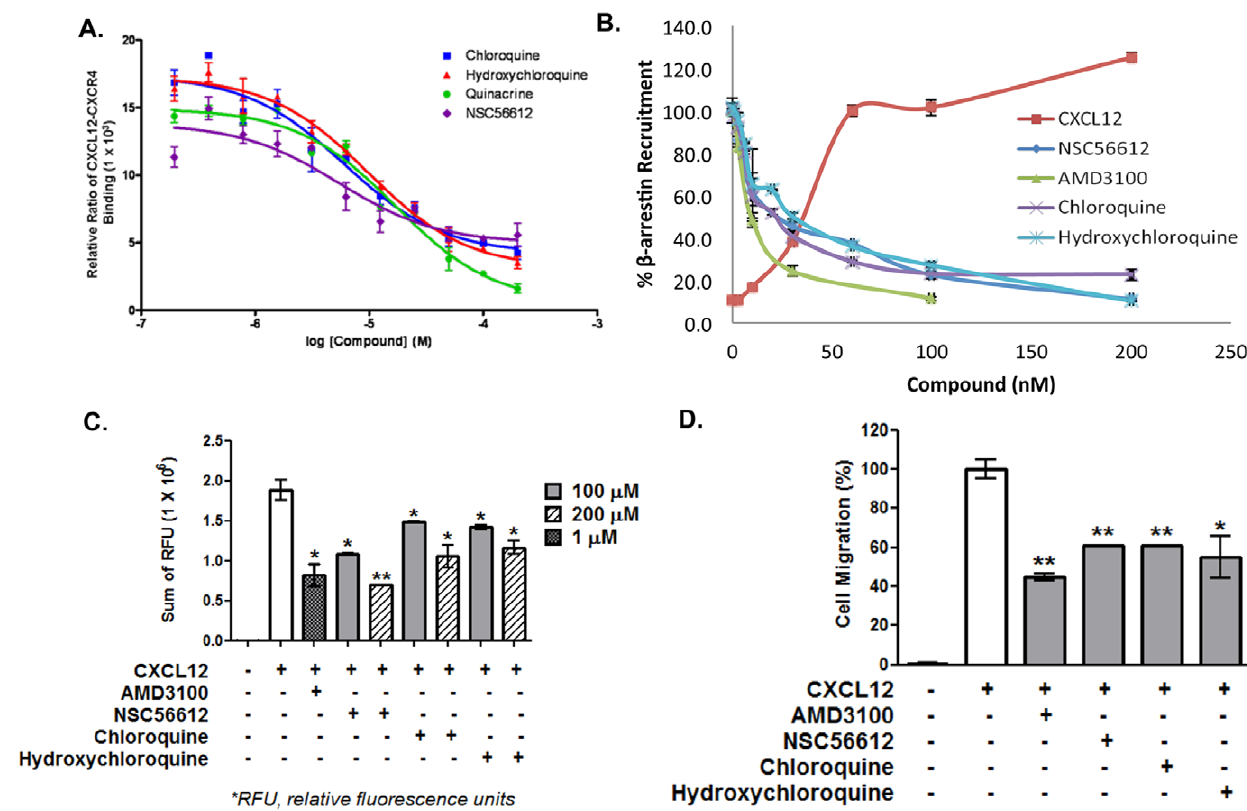
Figure 3. NSC56612, chloroquine, and hydroxychloroquine inhibit CXCL12-mediated activity. (A) Concentration dependent inhibition of fluorescently labeled CXCL12 (60 nM) binding to SNAP-tagged CXCR4 receptor in HEK293 cells by NSC56612, chloroquine, and hydroxychloroquine. The half maximal effective concentrations (EC 50 ), the values at which maximum CXCL12-CXCR4 binding is inhibited by 50%, for AMD3100, NSC56612, chloroquine, and hydroxychloroquine are 60.0 nM, 5.5 m M, 6.1 m M, and 9.8 m M, respectively. These curves are representative data from 3 experiments performed in duplicate. (B) Dose-dependent inhibition of CXCL12-induced b -arrestin-2-mediated beta-lactamase activity in engineered Tango assay by pretreatment with AMD 3100, NSC56612, chloroquine, and hydroxychloroquine. Emission data at 460/530 was defined as the response ratio. These curves are representative data from 3 experiments performed in duplicate. (C) Dose-dependent inhibition of CXCL12-induced intracellular calcium flux by AMD 3100, NSC56612, chloroquine, hydroxychloroquine. The CXCR4-mediated calcium influx was measured at 1 m M of AMD3100 and two different concentrations (100 m M and 200 m M) of the three compounds in Molt-4 cells. AMD 3100, NSC56612, chloroquine, and hydroxychloroquine showed 50 to 60% inhibition of CXCL12-induced calcium influx. These curves are representative data from 3 experiments performed in duplicate. (D) Inhibition of CXCL12-induced Jurkat cell migration in by AMD3100 (100 nM), NSC56612 (100 m M), chloroquine (100 m M), and hydroxychloroquine (100 m M). All four compounds showed 40% to 50% reduction in CXCL12-induced cell migration. The figure shows data from 4 experiments performed in duplicate. Error bars represent 6 one SD. Student t-test: * , 0.05 and ** , 0.01.